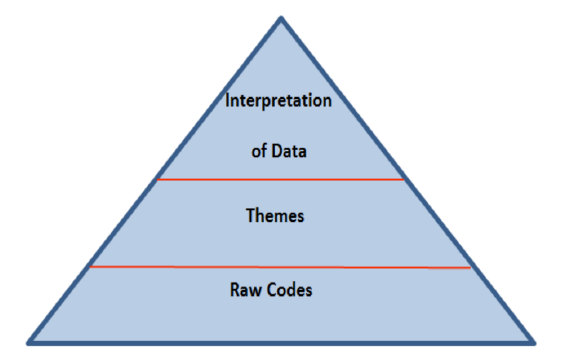
Figure 1. Pyramid of coding and analysis.